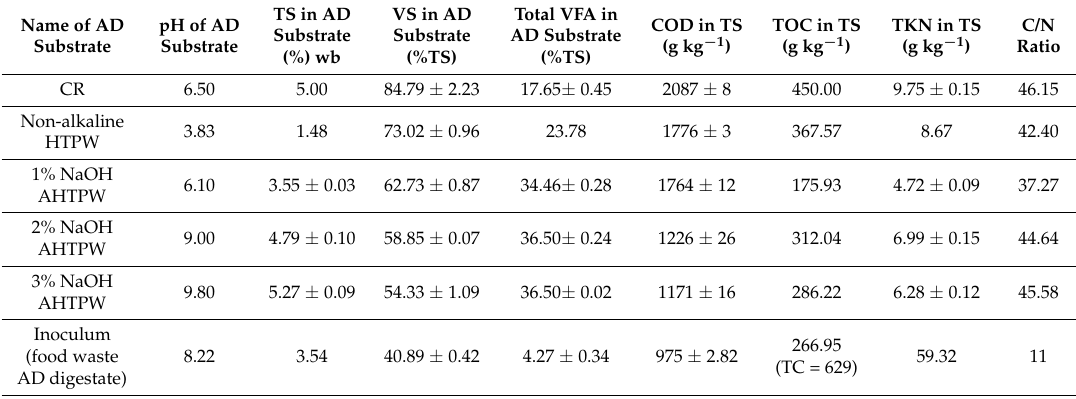
Table 2. Major compounds of CR, non-alkaline and alkaline HTPW organics and